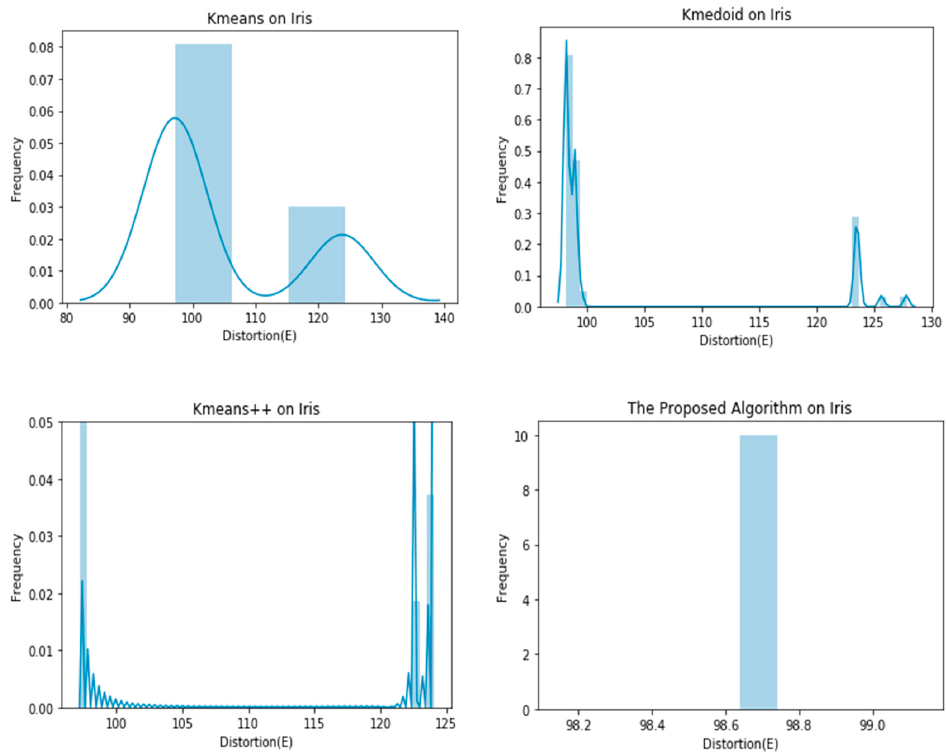
Informatics 2020 , 7 , x Figure 7. Graphical representation of E obtained by 100 runs of di ff erent algorithms on Iris dataset. Figure 7. Graphical representation of E obtained by 100 runs of different algorithms on Iris dataset.